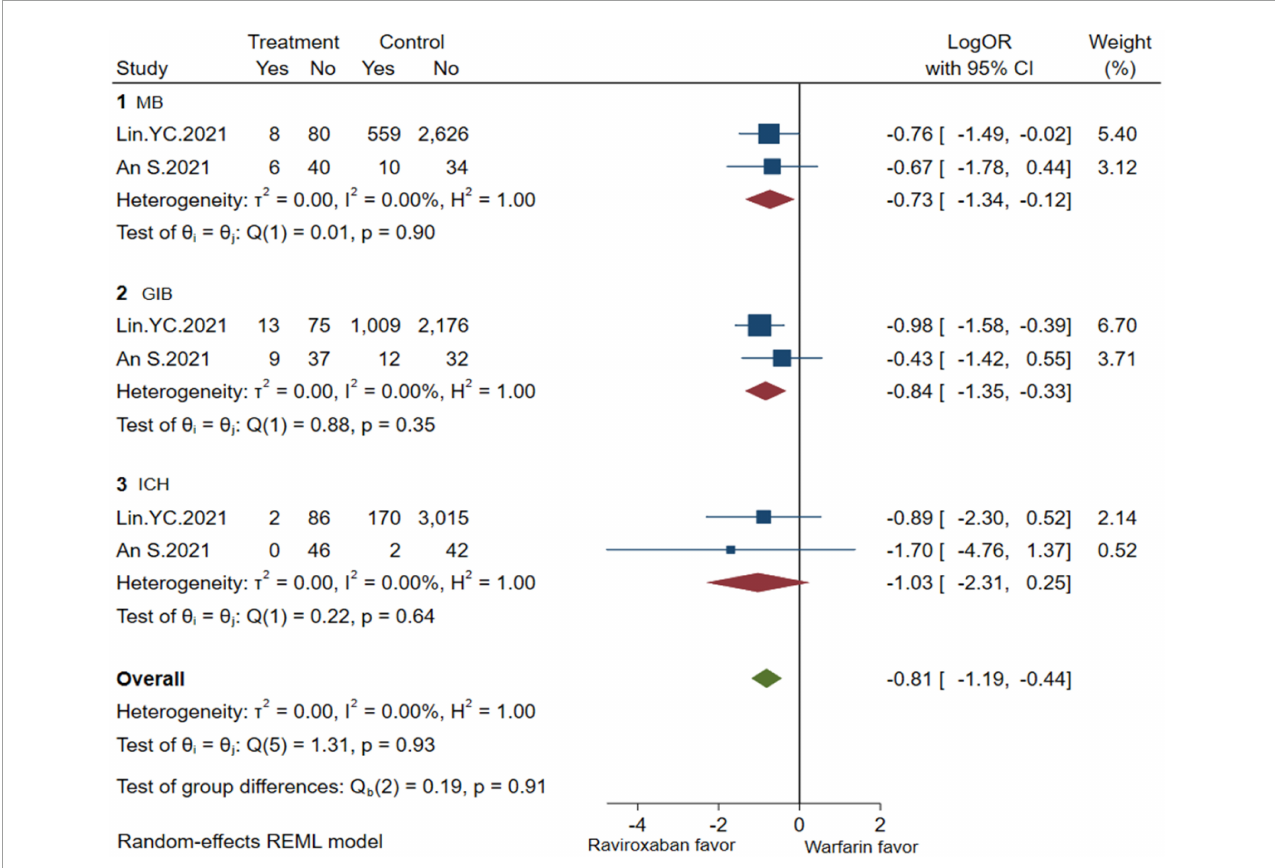
FIGURE5 Bleeding of low-dose rivaroxaban (MB, major bleeding; GIB, gastrointestinal bleeding; ICH, hemorrhagic